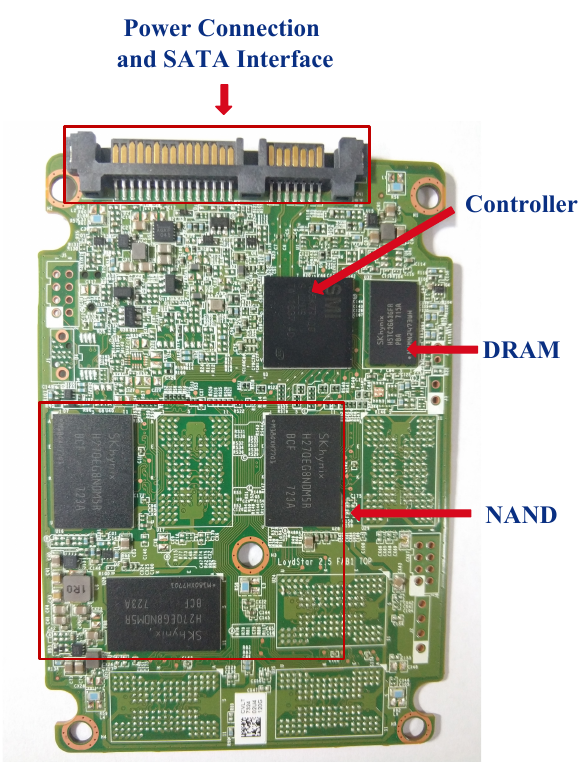
Figure 1. A solid-state drive (SSD) sample with case removed and notable components identified. Table 2. SSD Architecture And Baseline